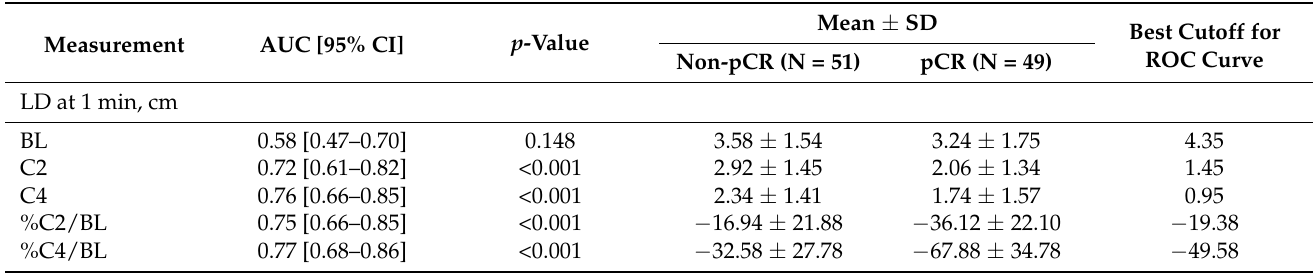
Table 2. Longest tumor dimension (LD), tumor volume (TV), and enhanced tumor volume (ETV) measurements by neoadjuvant systemic therapy response